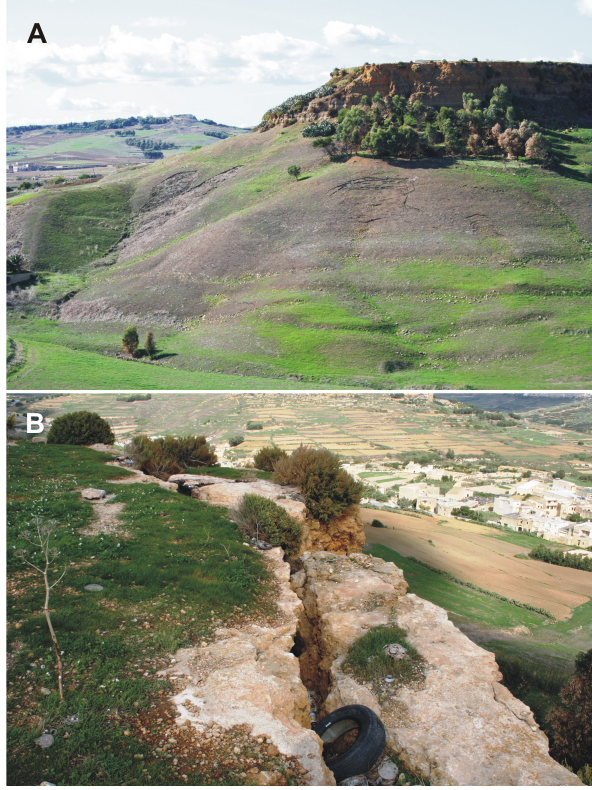
Fig. 17. Field validation of the numerical modelling results. (A) : General view of the Gelmus Hill, close to Citadel; (B) : Detail of the outer portion of the rock